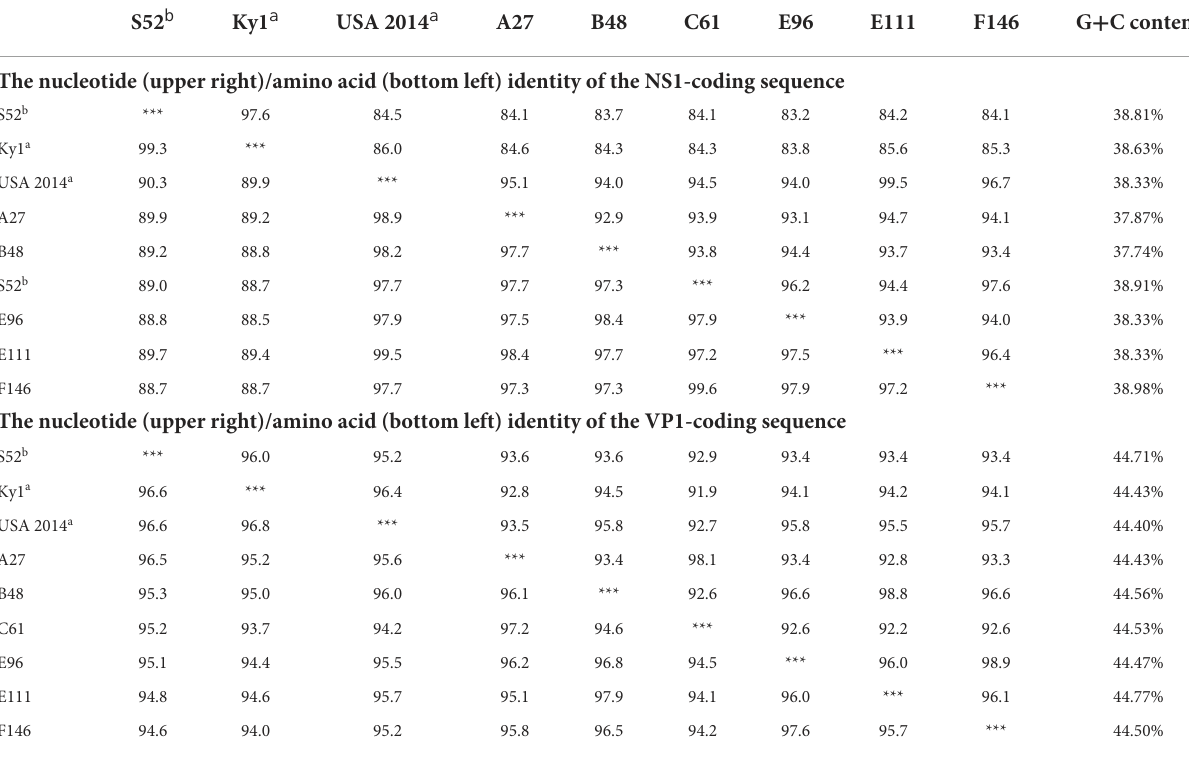
TABLE 4 Analysis of the nucleotide (upper right)/amino acid (bottom left) identity of the NS1 and VP1-coding sequences among EqPV-CSF strains. S52 b G + C content The nucleotide (upper right)/amino acid (bottom left) identity of the NS1-coding sequence S52 b